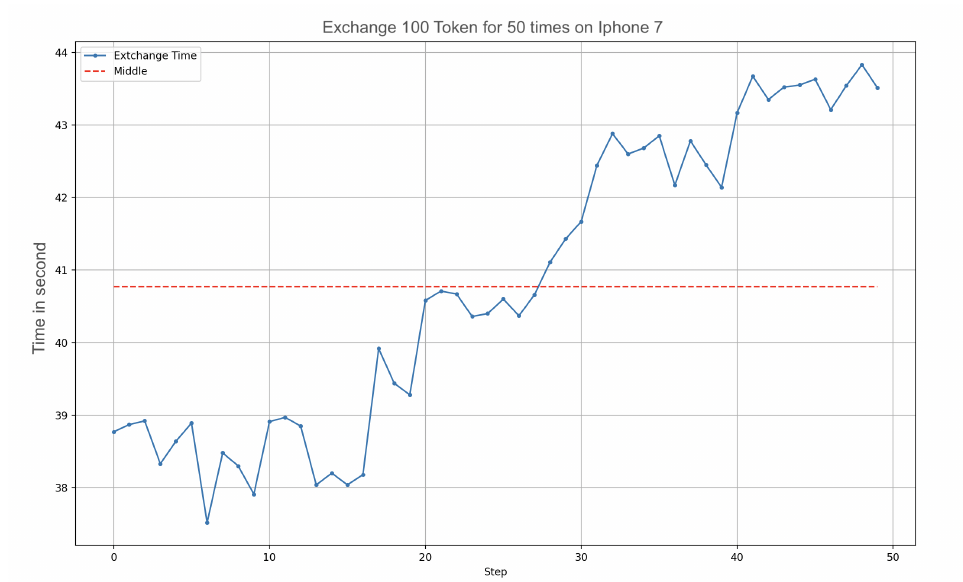
Figure 13. Sending 100 tokens, 50